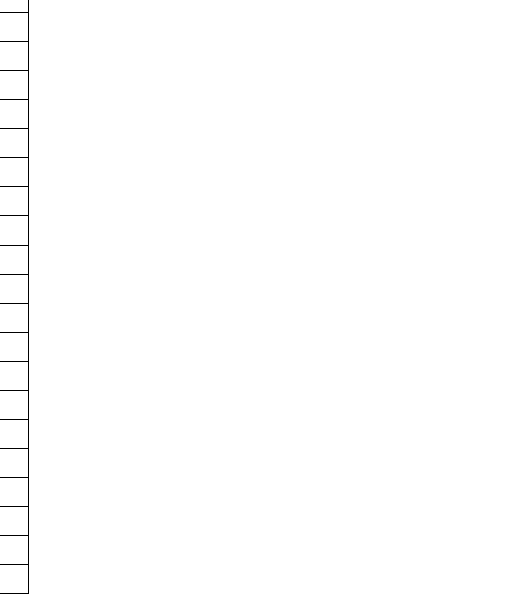
Table 1. Result of accumulative sequence with